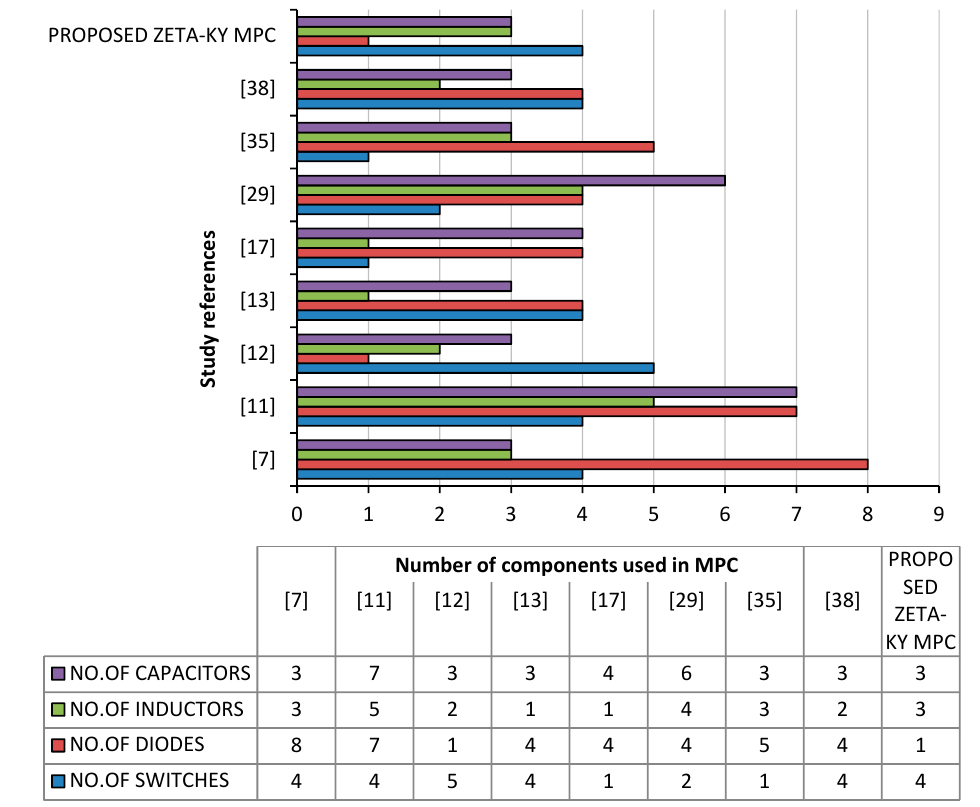
Figure 19. Comparison of conventional multiport converters with the proposed modified triple port converter on the basis of components employed.